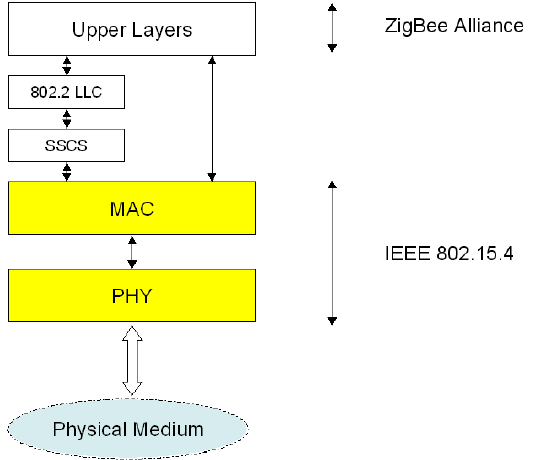
Figure 5. ZigBee protocol